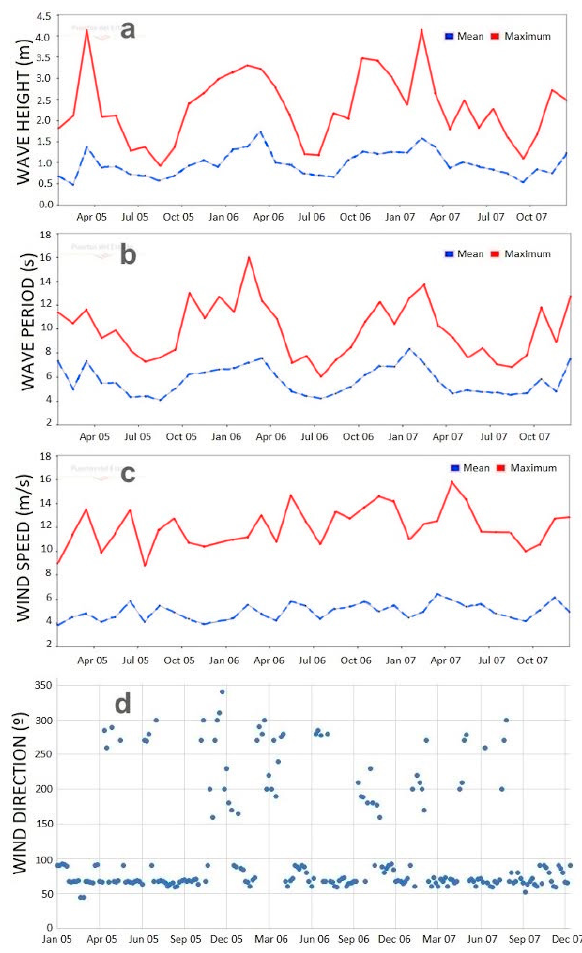
Figure 2. Temporal series of ( a ) wave height (m); ( b ) wave period (s); ( c ) wind speed (m/s); ( d ) most frequent wind direction: N = 0°, E = 90°, S = 180°, W = 270° (adapted from www.puertos.es). The dotted blue line refers to the average value, while the red one is the maximum value registered.